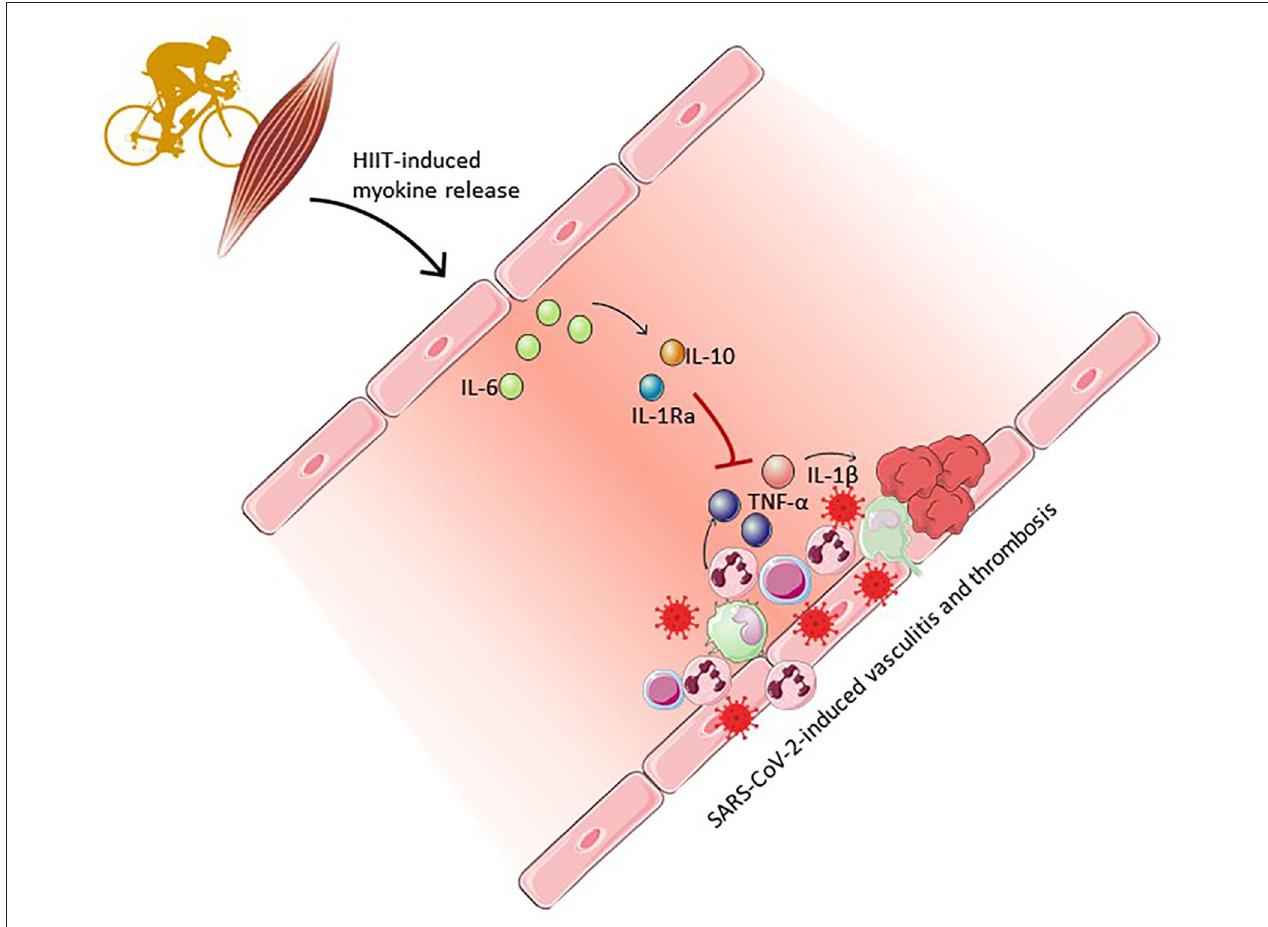
FIGURE 1 | High-intensity interval training (HIIT)-induced myokines (IL-6, IL-10 and IL-1Ra) may counter-act systemic vasculitis through an anti-inflammatory response, namely inhibition of TNF α and IL-1 β -mediated activation of pro-coagulant and pro-inflammatory pathways. Clipart provided by Servier Medical Art (